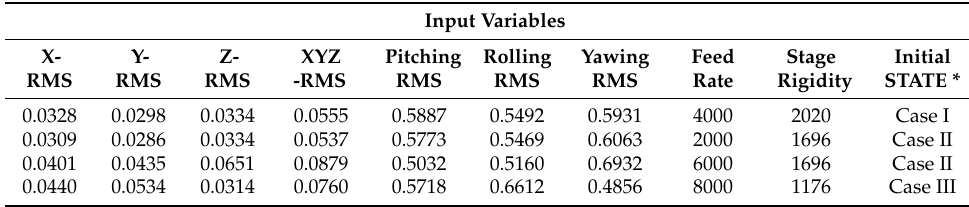
Table 5. Sample data for ANN